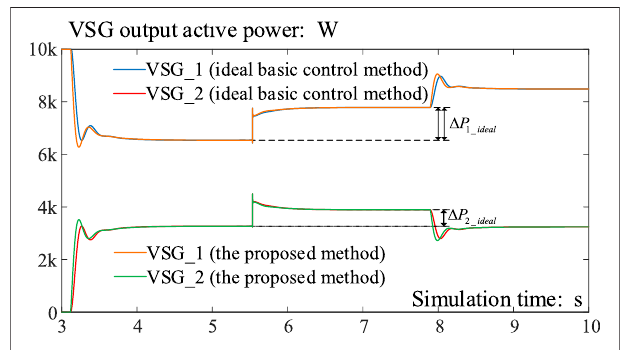
FIGURE 11 | Simulation results II: multi-VSGs with the same control method.